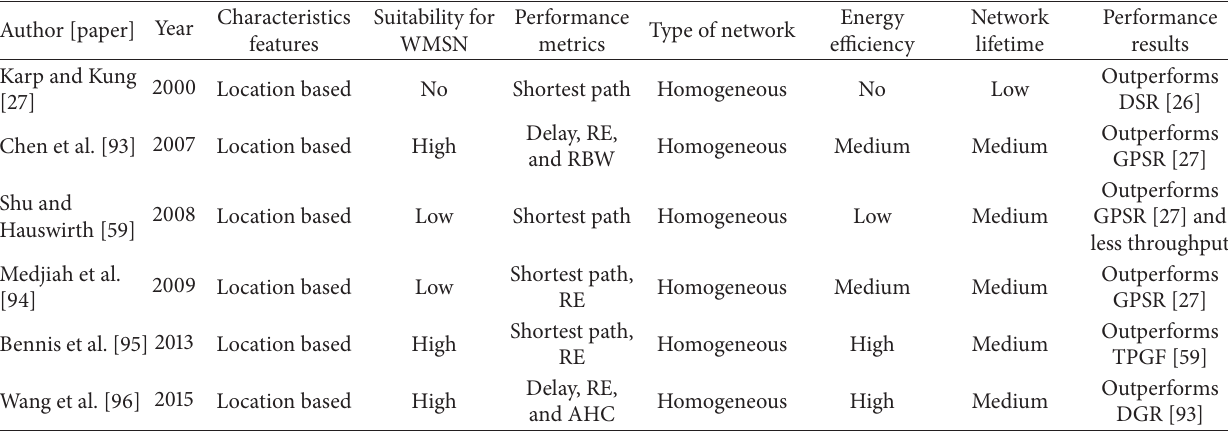
Table 7: Location based routing